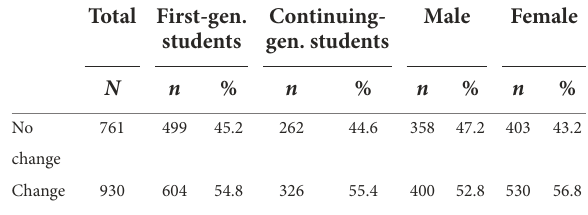
TABLE 5 Frequencies of first-generation, continuing-generation, female, and male students’ changes from study program aspiration to study program